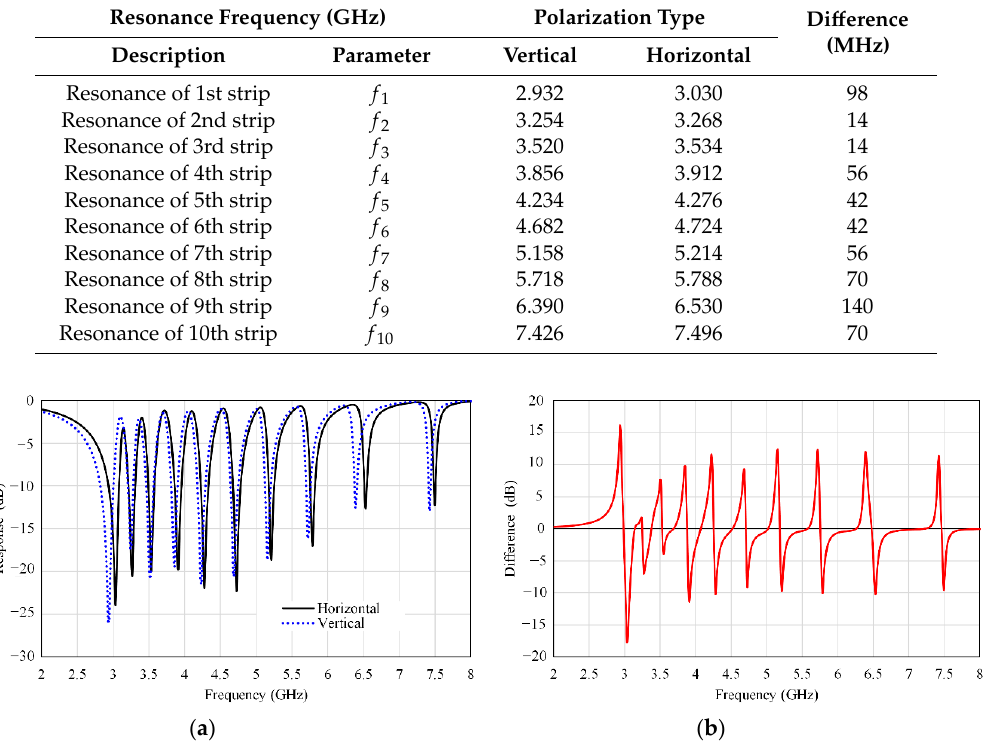
Figure 9. Code: 1111111111. ( a ) Frequency responses under excitation with vertical and horizontal polarizations. (b ) The amplitude difference in dBs between the two responses.